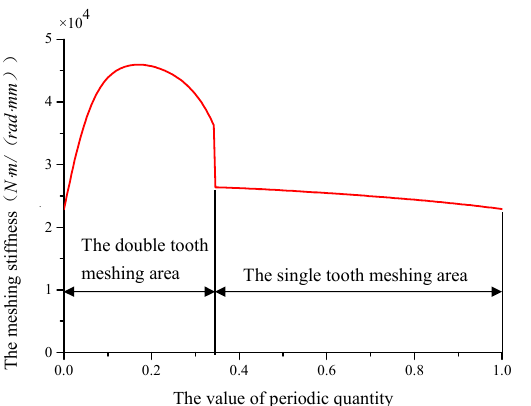
Figure 23. Time-varying meshing stiffness curve of rack of the trochoidal roller pinion rack.